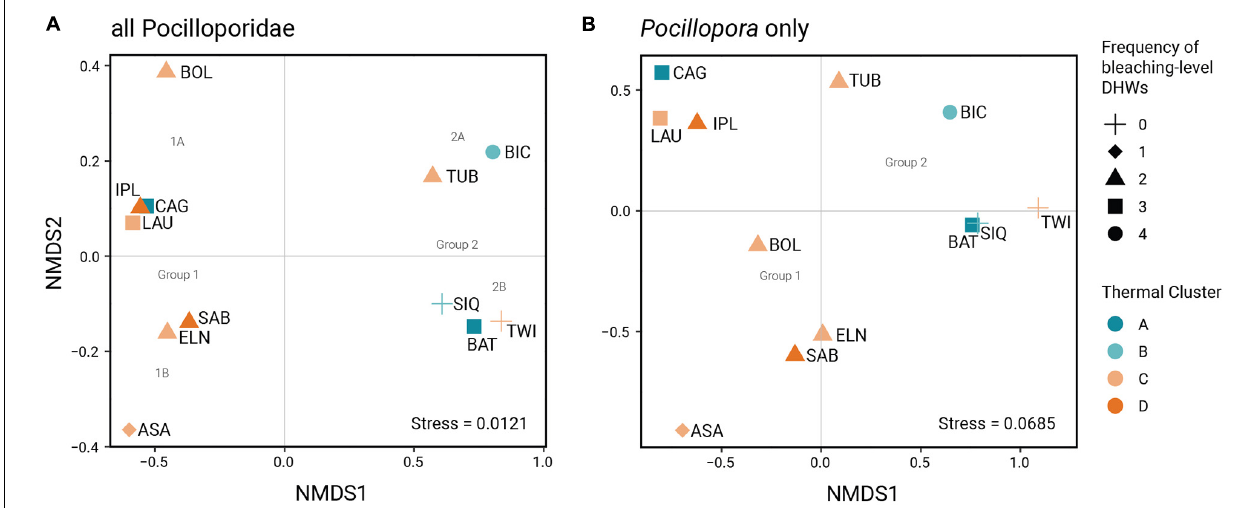
FIGURE 3 | Ordination plots from the non-metric multidimensional scaling analysis for (A) all-Pocilloporidae and (B) Pocillopora -only datasets, which suggest two broad groupings that coincide with thermal cluster and four subgroupings according to symbiont